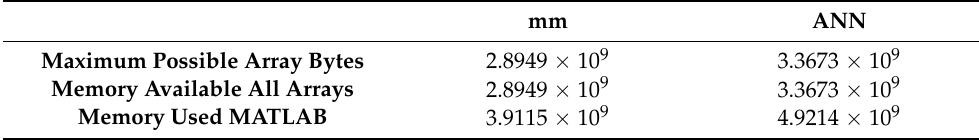
Table 5. Evaluation of the performance in terms of memory